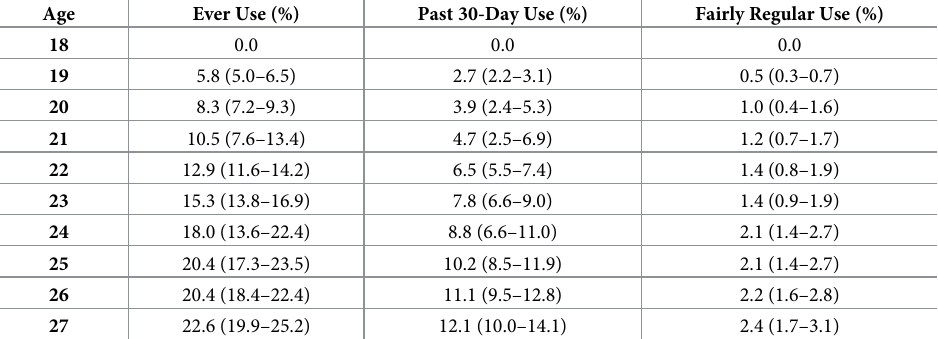
Table 2. Estimated hazard functions a (and 95% confidence intervals b ) of the age of initiation of hookah use behav- iors for PATH¥ young adults (aged 18–24).